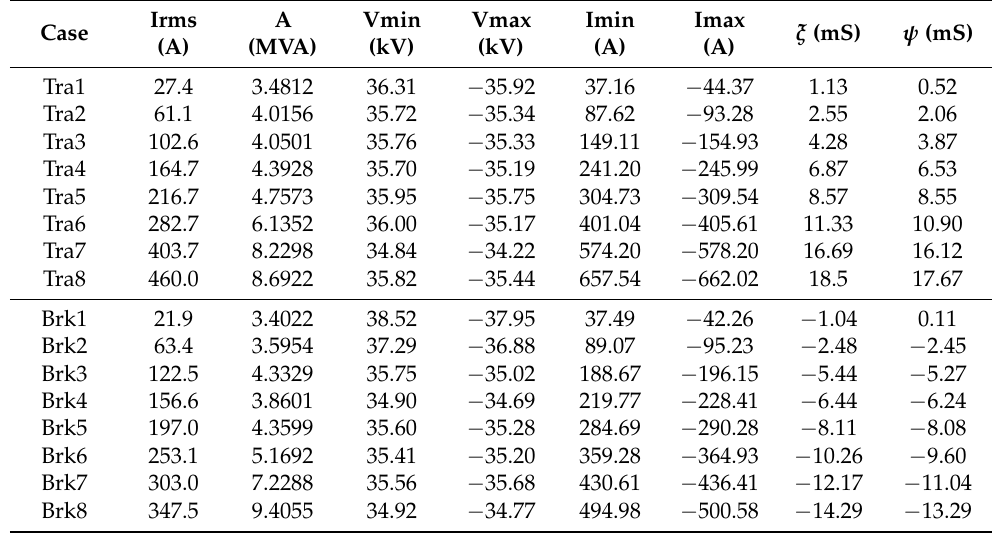
Table 3. VI diagram parameters for France (case numbering from 1 to 8, following Figure